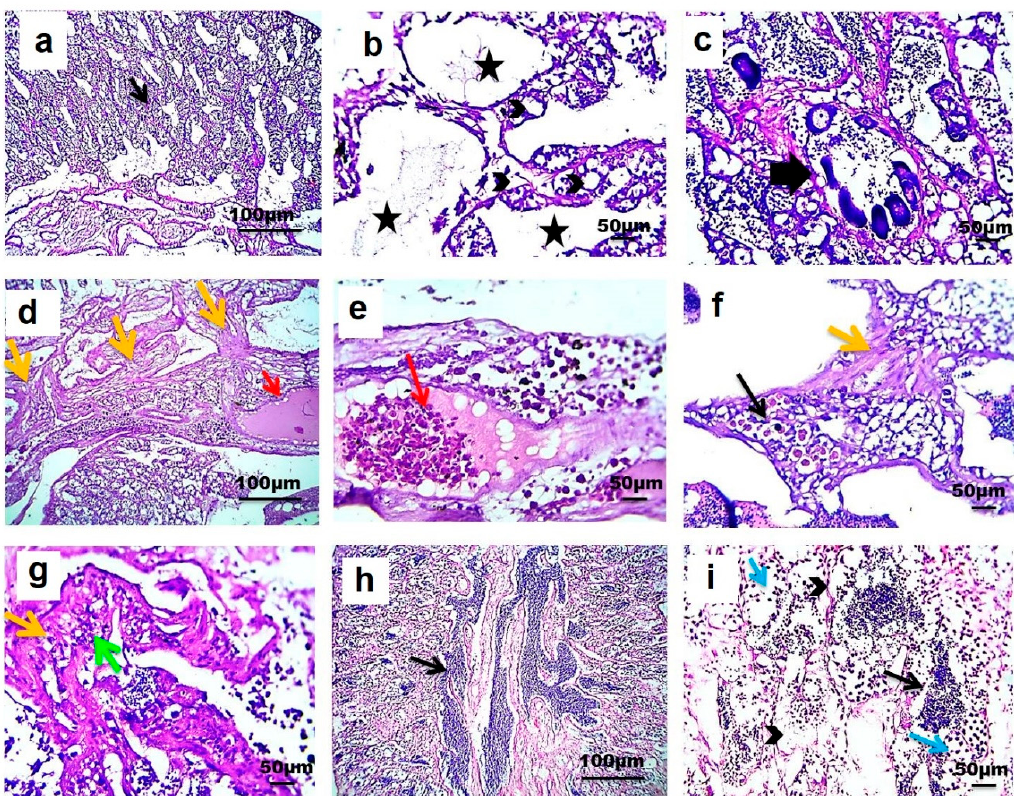
Figure 6. Microscopic pictures of testes from site 1 (S1): a and b –show vacuolization of seminiferous epithelium (arrowheads) with the absence of spermatozoa from the lumen of the testicular lobule (asterisks), c –Developmental stages of oocytes are seen inside testicular lobule (thick arrow), d , f , g –with an increased amount of interstitial of connective tissue (orange arrows); d and e –congestion (red arrows), f –melanomacrophage center (black arrow), g –inflammation (green arrow). Testes from site 2 (S2): h and i –shows a reduced number of mature sperms (black arrows) with more vacuolization of seminiferous epithelium (arrowheads) and fewer numbers of spermatogonia and spermatocytes (blue arrows). hematoxylin and eosin (H&E), X: 100 ( a , d , h ) and X: 400 ( b , c , e , f , g , i ).